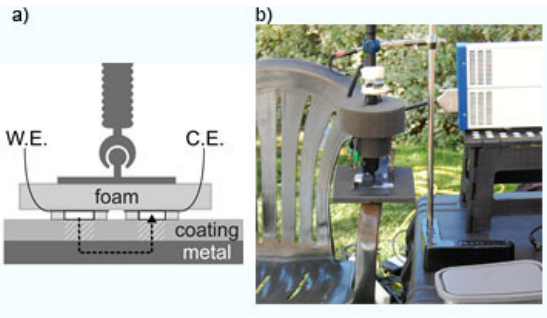
Figure 2. ( a ) Diagram of the hydrogel EIS cell used for both outdoor sculptures and test panels. Relative sizes of the components are exaggerated for illustrative purposes; ( b ) Photograph of the EIS cell being used during a measurement of C1.